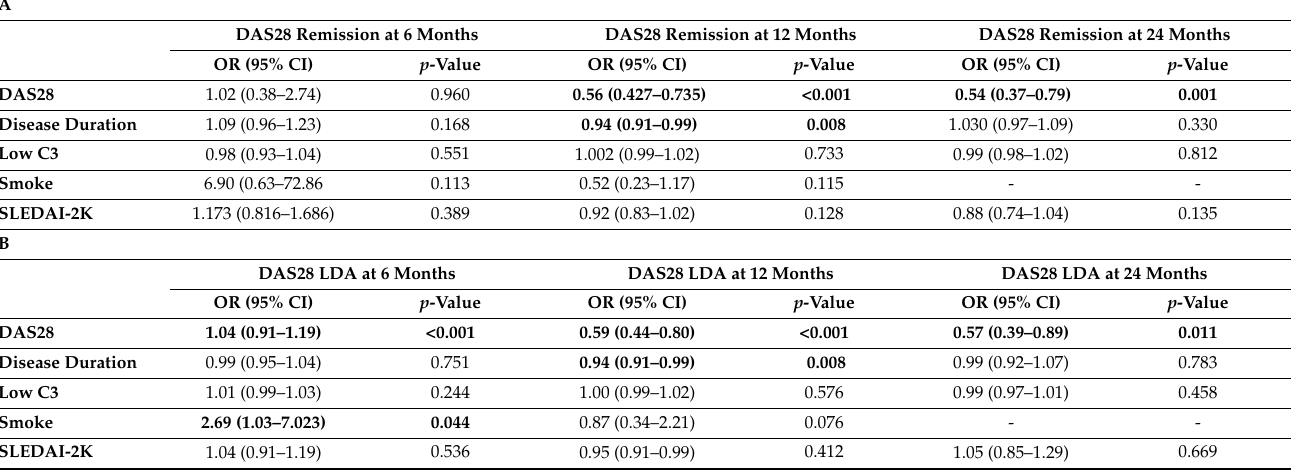
Table 3. Baseline predictors of DAS28 remission (A) and LDA (B) at 6, 12, and 24 months (multivariate